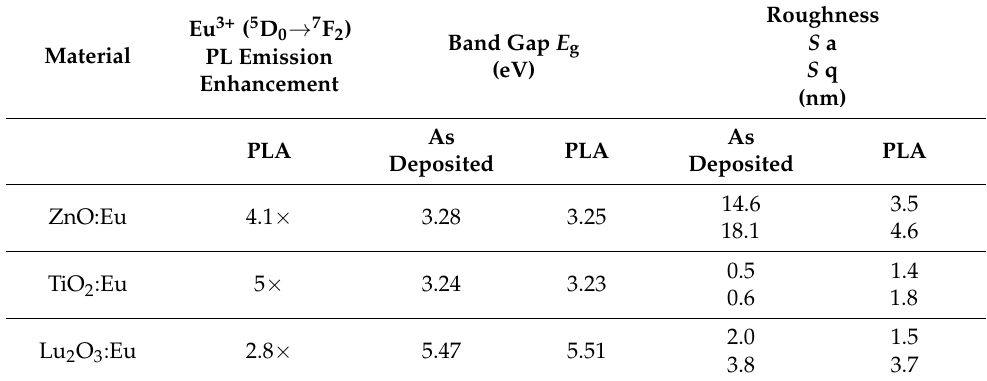
Table 2. Properties, modifications after